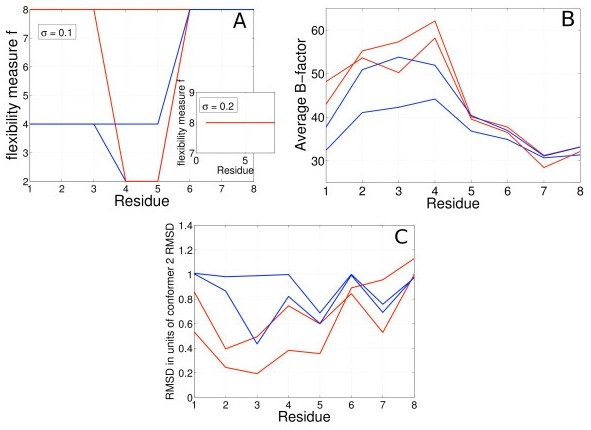
Comparative analysis. A) Pflex is sensitive to the parameter σ, producing false-positives at low values and false-negatives at higher values (inset). B) Average B-factors correctly identify the regions of variability, but cannot distinguish between true variability and variability due to noise. C) Choosing a RMSD cutoff for classification is difficult with noisy coordinates. The color code is the one used in Figures 2 and 3.